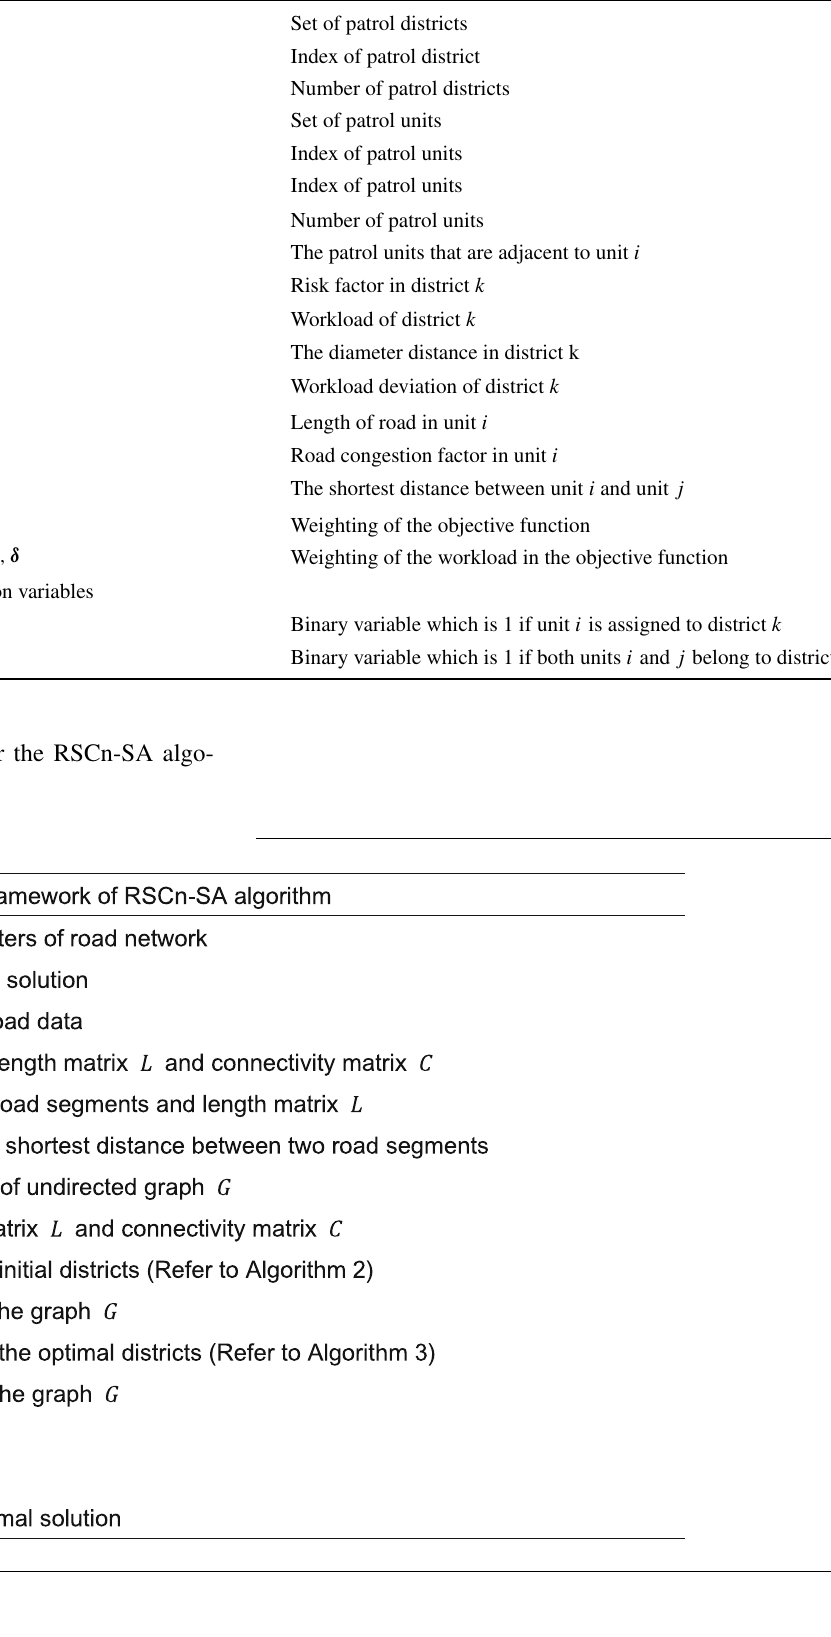
Table 1 The parameters and decision variables in the